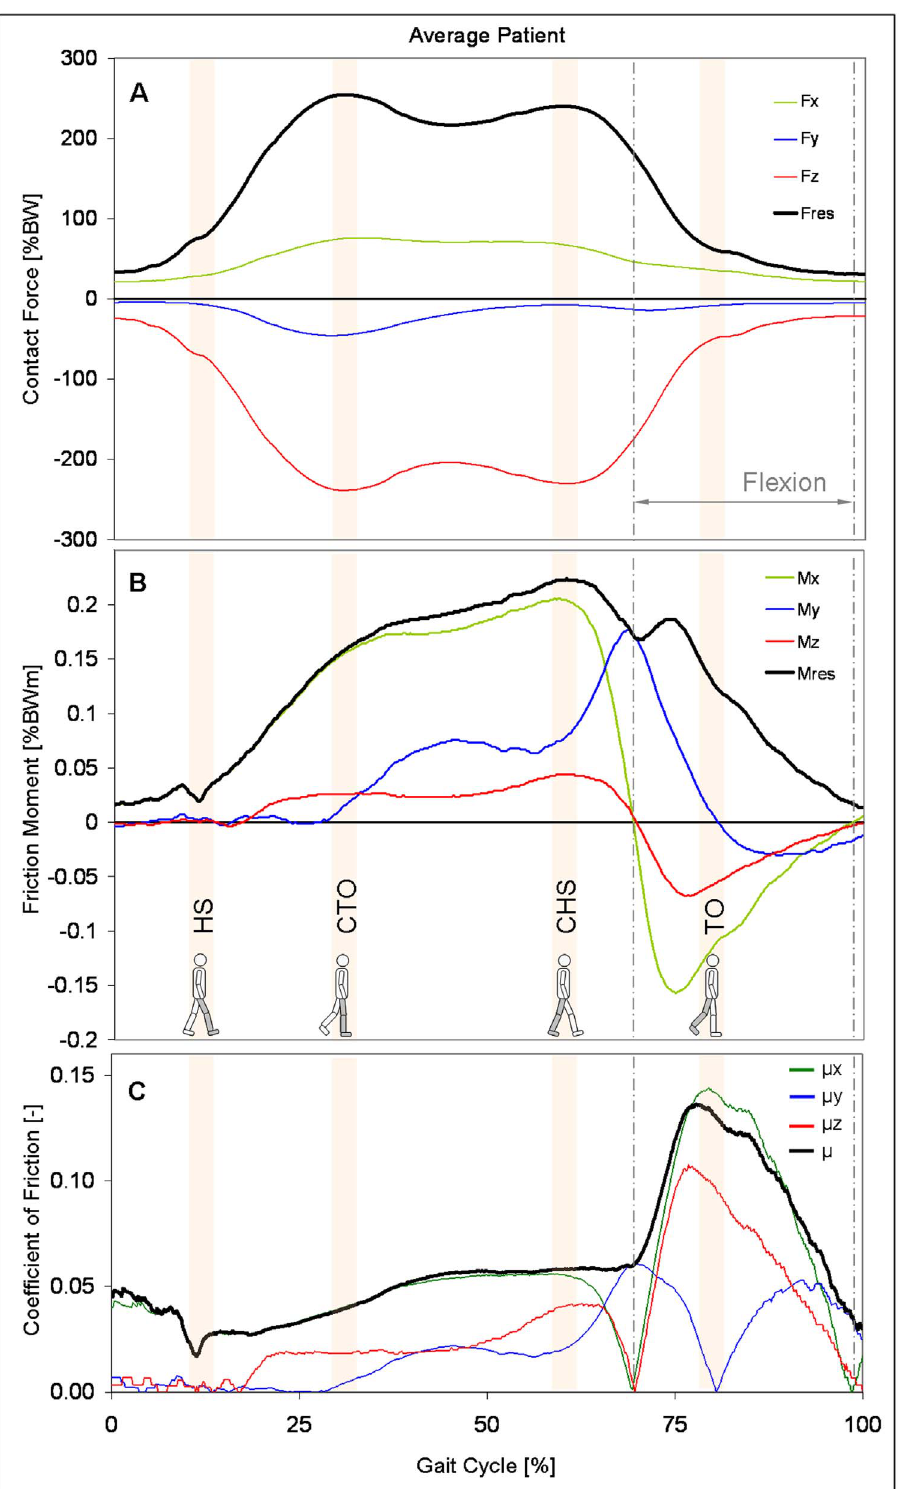
Figure 2. Time courses of contact force, friction moment, and coefficient of friction. Top: contact force F res and its components. Middle: friction moment M res and its components. Bottom: coefficients of friction. m from 3D calculation; m x (sagittal plane), m y (frontal plane), and m z (horizontal plane) from simplified 2D calculations. The data presented are for an average subject during level walking at approximately 1 m/s. Vertical lines: borders of the flexion phase. The diagram starts before heel strike.